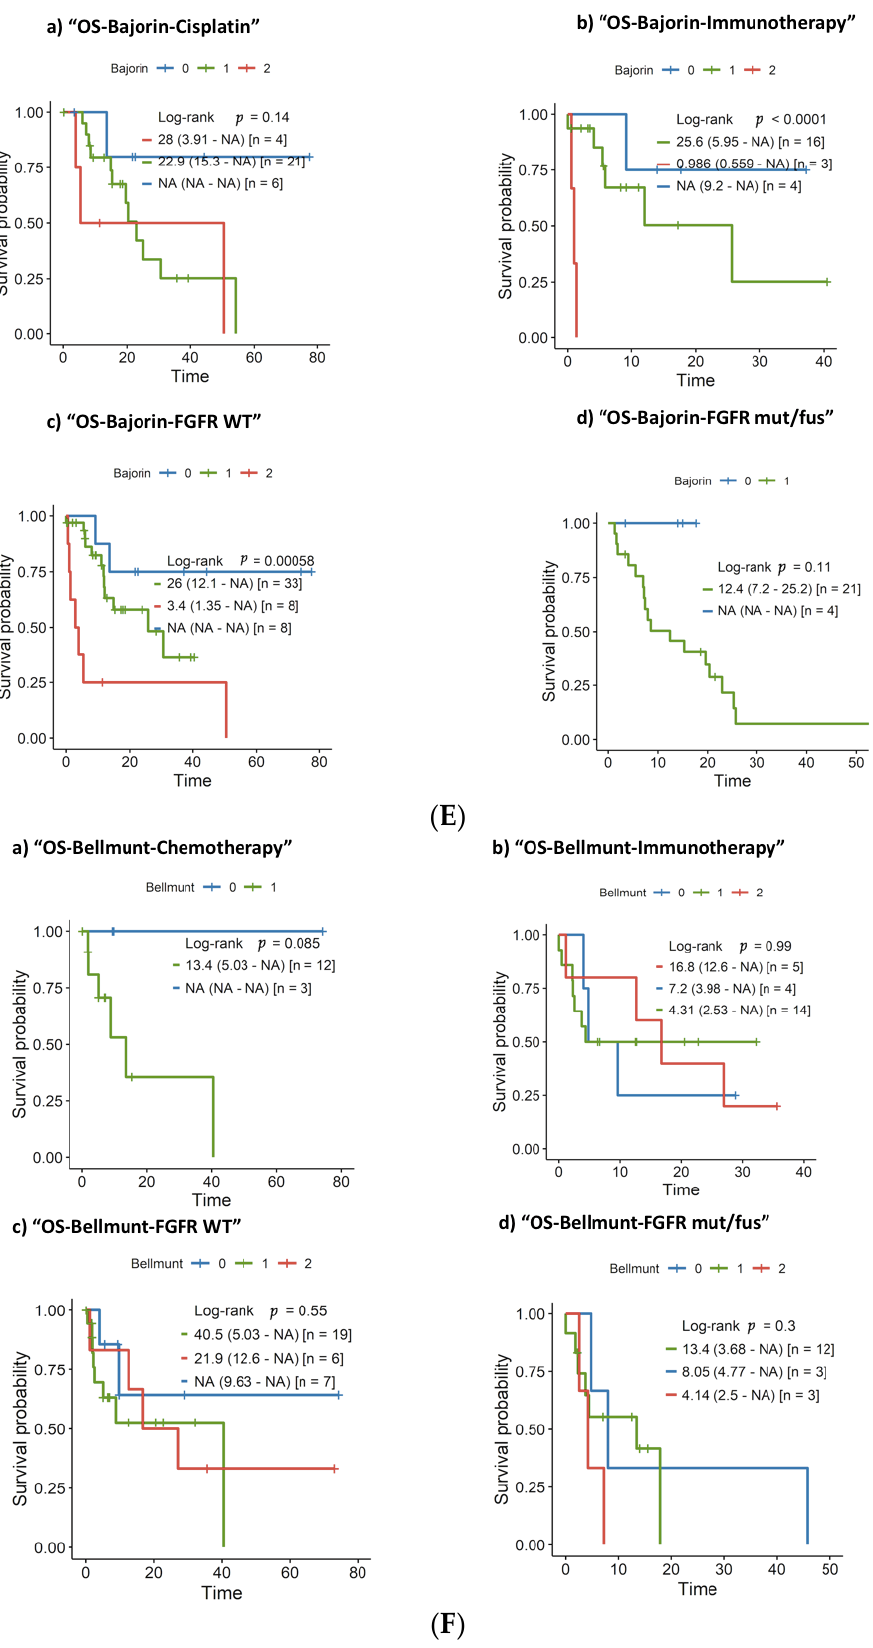
Figure 1. ( A ) Study population flowchart. ( B ) Progression-free survival according to FGFR genomic alterations. ( C ) Overall survival according to FGFR status. ( D ) Overall survival according to FGFR status in patients with liver metastases, bone metastases, visceral metastases, or lymph node only metastases. ( E ) Bajorin ’ s criteria in patients treated with first-line cisplatin-based therapy ( a ) and immune therapy ( b ); Bajorin ’ s criteria in FGFR WT patients ( c ); Bajorin ’ s criteria in FGFR mut/fus patients( d ). ( F ) Bellmunt ’ s criteria for overall survival in patients treated with second-line chemo- therapy ( a ) and immune therapy ( b ); Bellmunt ’ s prognostic factors in FGFR WT patients ( c ) and FGFR GA patients ( d ). Table 1. Study population demographics ( n = 77) and comparison between FGFR GA and WT pa- tients.